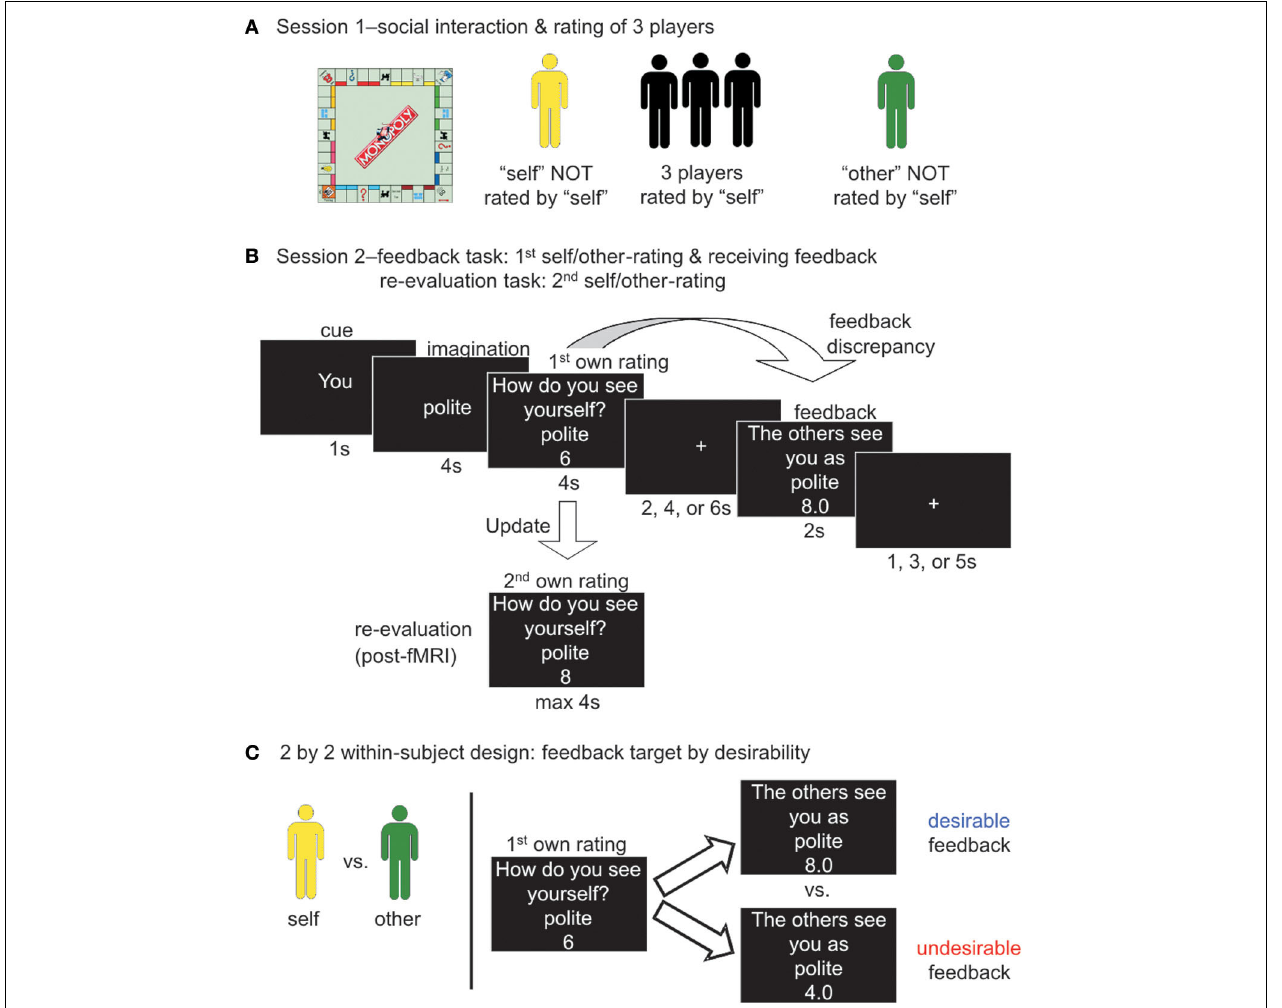
FIGURE 1 | Experimental design—receiving social feedback from peers afterareal-lifeinteraction.(A) Participantscametothelaboratoryingroupsof either five German or five Chinese participants. In the first session of the experiment, participants got to know each other by playing the board game “monopoly” for 1h 15min. Afterwards, each person rated three of the other playerson40positiveand40negativetraitadjectives(SupplementaryTableS1) on a Likert scale from 1 (this trait does not apply to the person at all) to 8 (this trait applies to the person very much). Participants did not rate themselves (yellow) and did not rate one of the other players (green). (B) In the second session,participantsinBerlinperformed thefeedback taskinthefMRIscanner and participants in Beijing performed the feedback task on a PC. In each trial, participantsfirstsawacueindicatingwhetherthetrialwasaboutthemselvesor about the other person whom they had not rated during the first session. They had to imagine how much one of the 80 traits applied to themselves or to the other person. They first gave their own rating and then saw the feedback rating